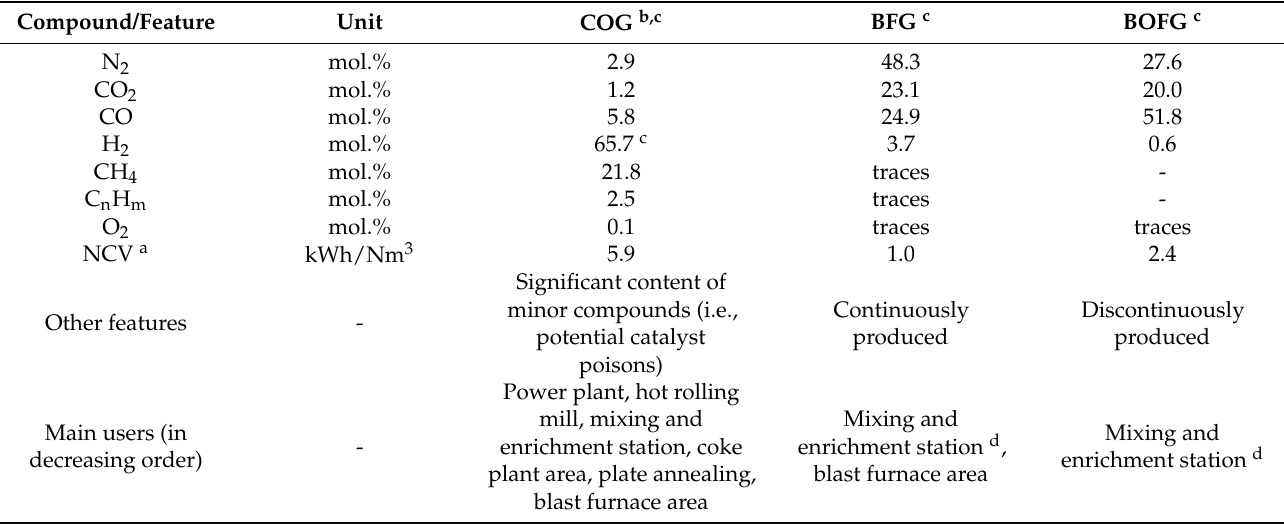
Table 1. Main process off-gas features (averages)